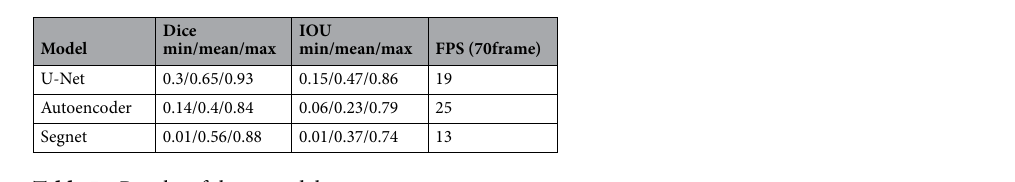
Table 5. Results of three